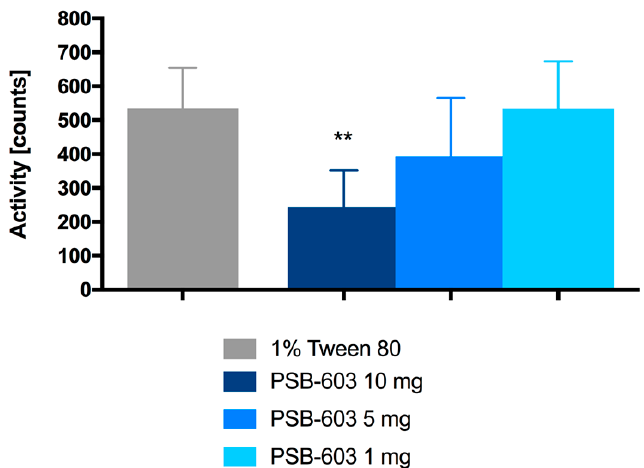
Figure 4. Locomotor activity after a single intraperitoneal administration of PSB-603. Results are expressed as means ± SD, n = 8–10. Comparisons were made by one-way ANOVA Bonferroni post hoc, * significant against control mice; ** p < 0.01.